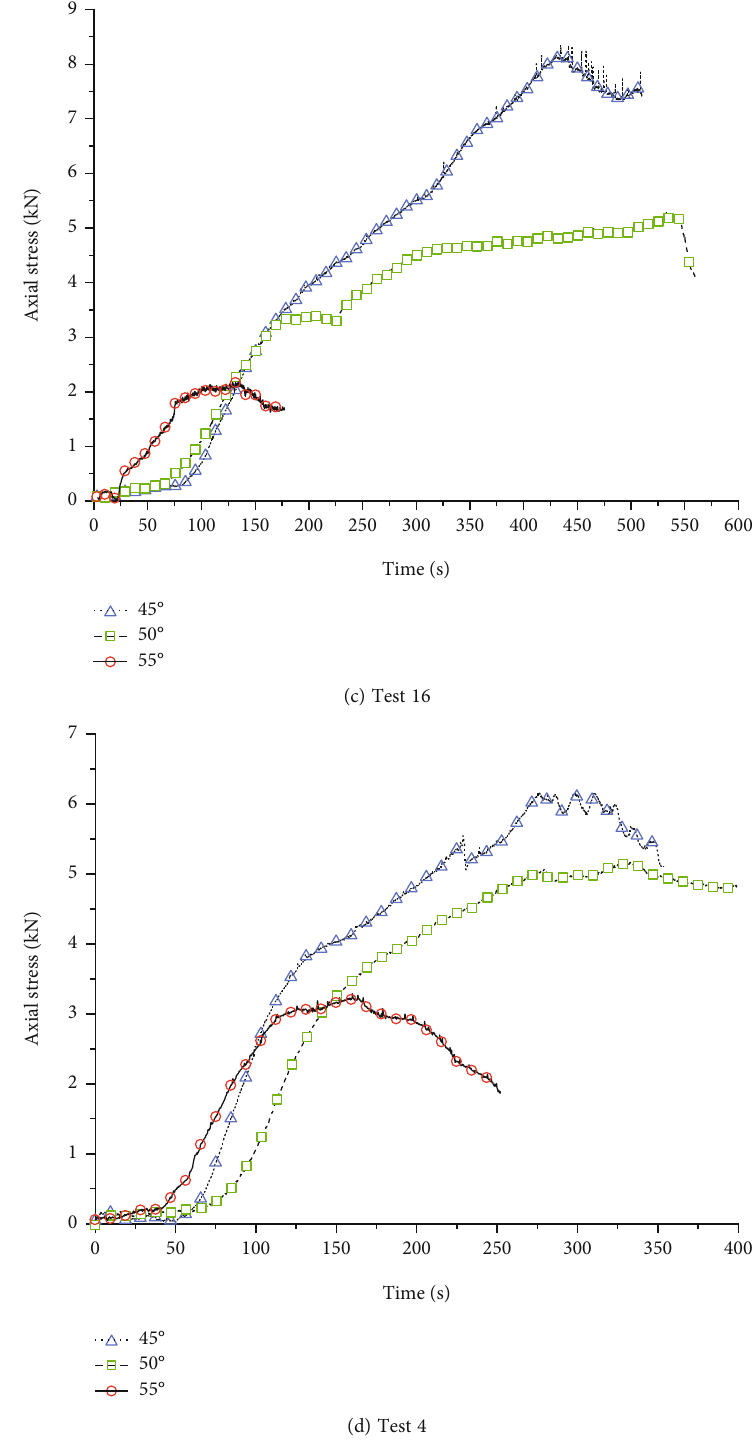
Figure 7: Shear axial pressure-time curve of secondary diagenesis